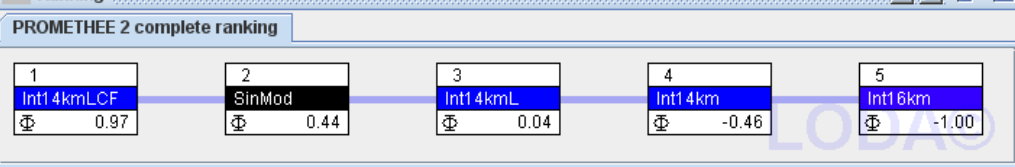
Figure 2. Environmental